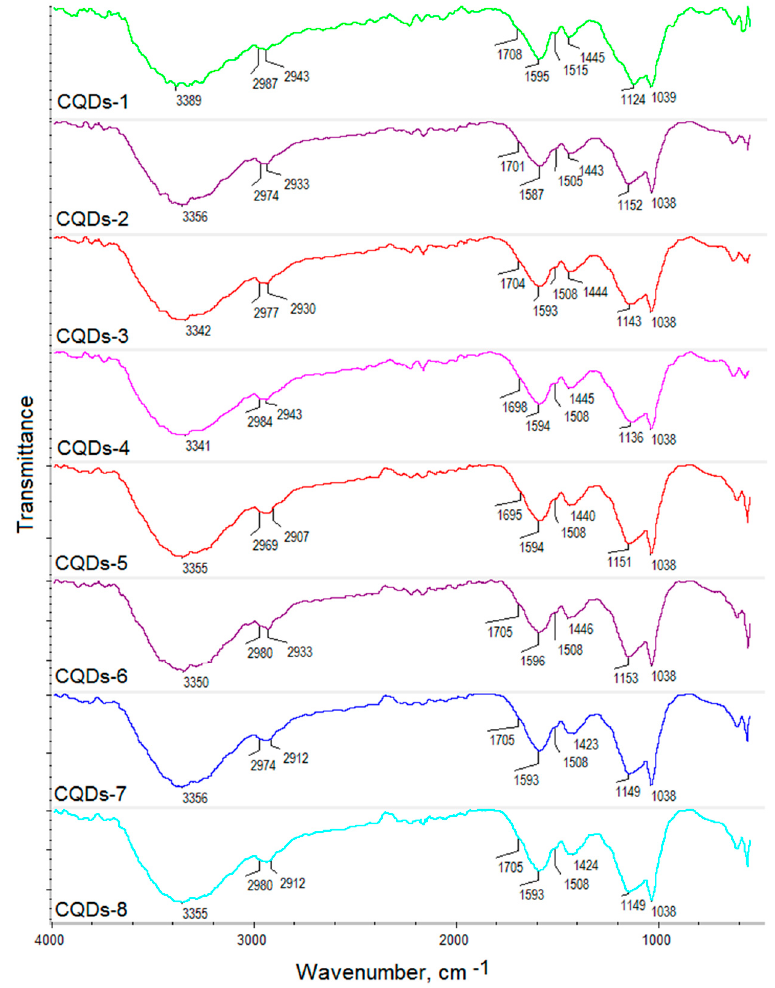
Figure 5. FT-IR spectra of the prepared coumarin-modified Figure 5 . FT-IR spectra of the prepared coumarin-modified CQDs .